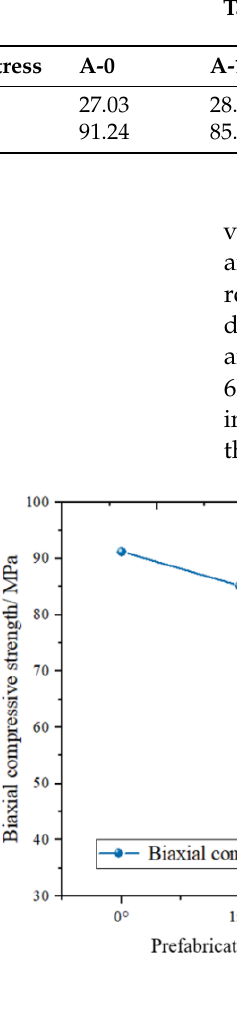
Figure 5. Biaxial compressive strength of different types of samples. ( a ) Fault dip angles ‐ Biaxial compressive strength curve; ( b ) Distance from fault to hole center ‐ Biaxial compressive strength curve.